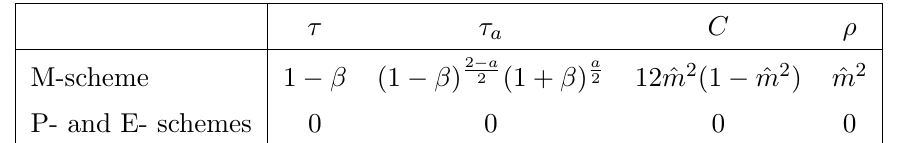
Table 1 . Threshold position for various event shapes in the case of primary production of a stable quark-antiquark pair in di(cid:11)erent massive schemes. We use (cid:12) = at threshold in natural